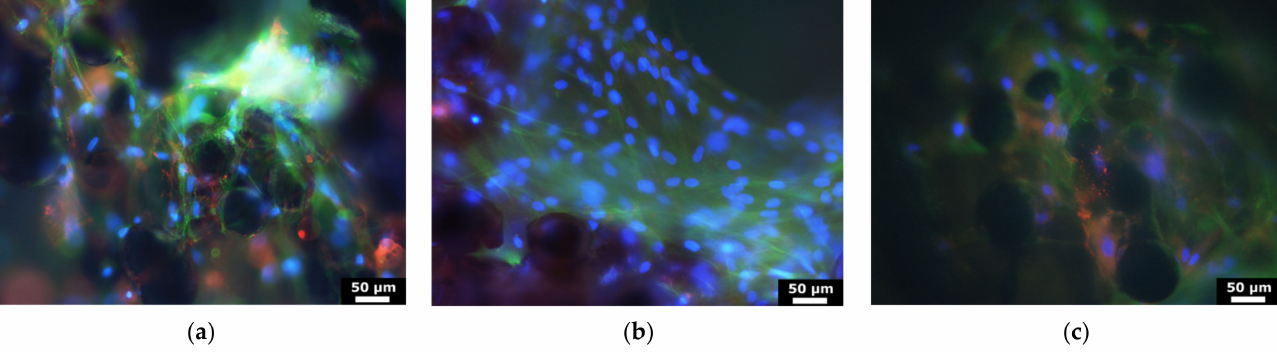
Figure 6. Microscopy images of cells, which are grown out of BC onto Ti-disk with different surface textures: ( a ) solid Ti-disk, ( b ) wurtzite and ( c ) honeycomb. Cells were immunostained with alkaline phosphotase (red), collagen-I (green) and DAPI (blue) prior imaging.